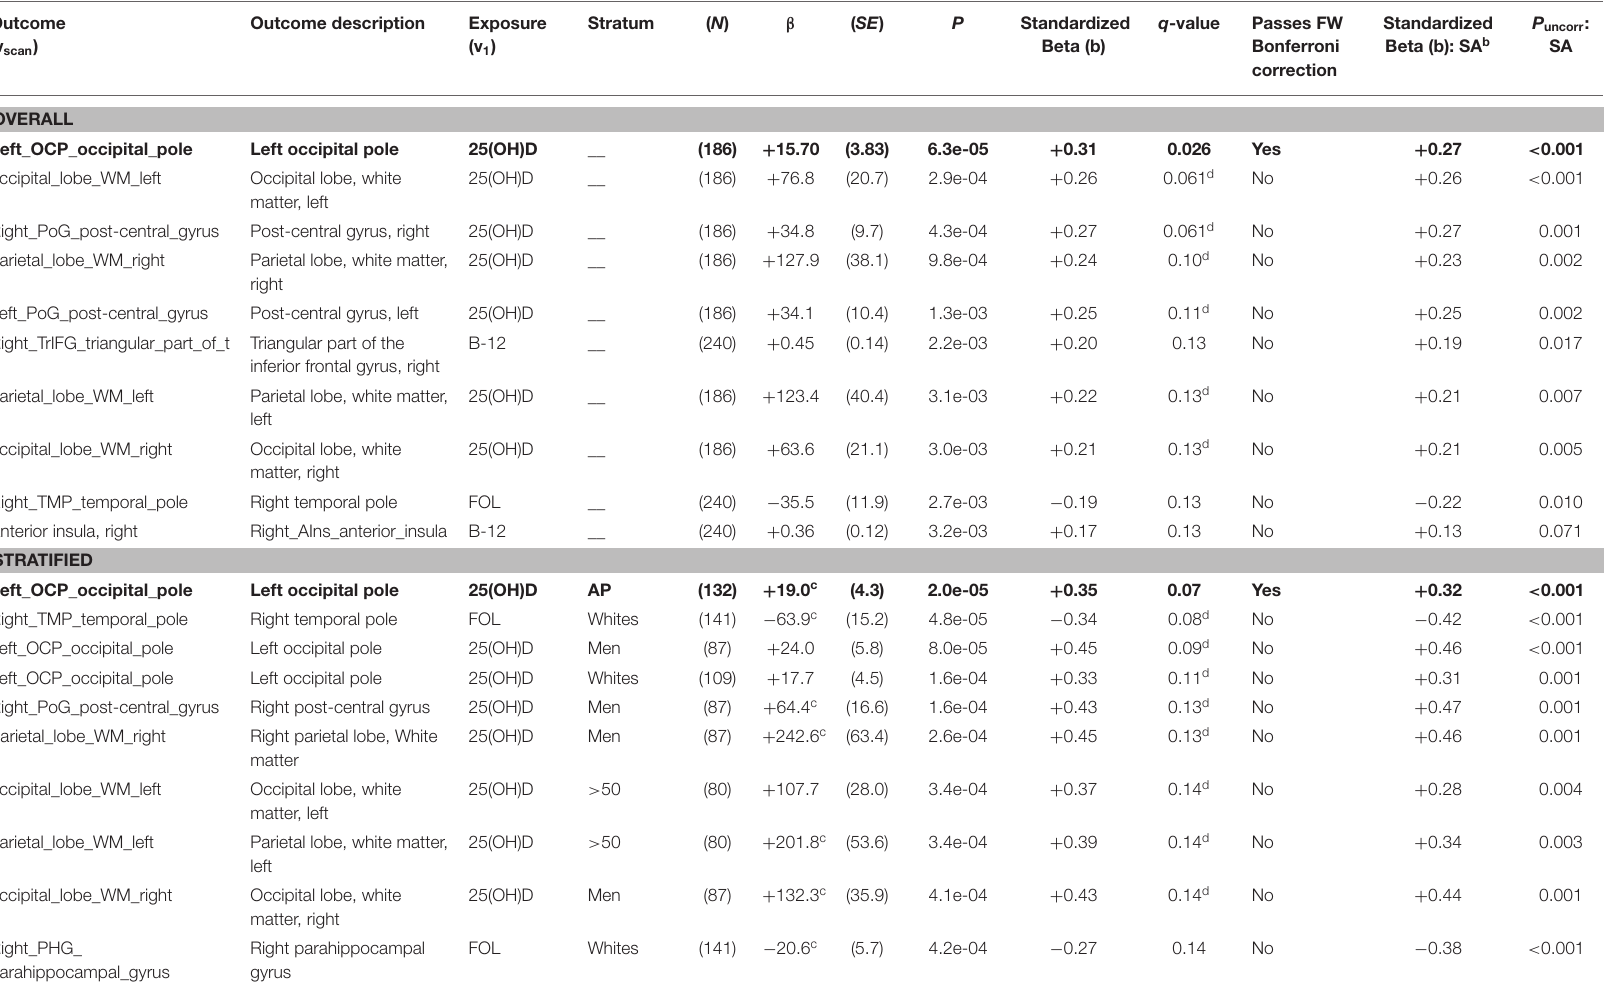
TABLE 3 | Top 10 adjusted associations from model C, small sMRI regions vs. visit 1 exposures: serum 25(OH)D, folate and cobalamin (overall and stratified analysis) with uncorrected P < 0.05: ordinary least square brain scan-wide analyses on HANDLS 2004–2009 and HANDLS-SCAN 2011–2015 a . Outcome Outcome description Exposure (v scan ) (v 1 )